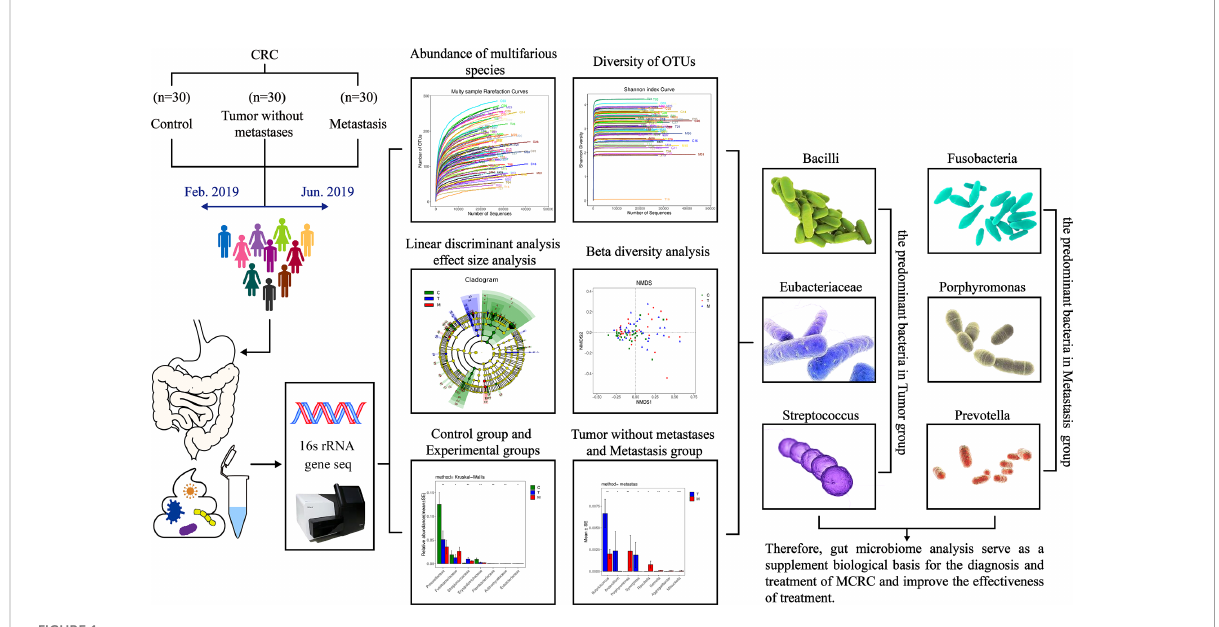
FIGURE 1 Human gut microbiome in colorectal cancer (CRC) without metastases and